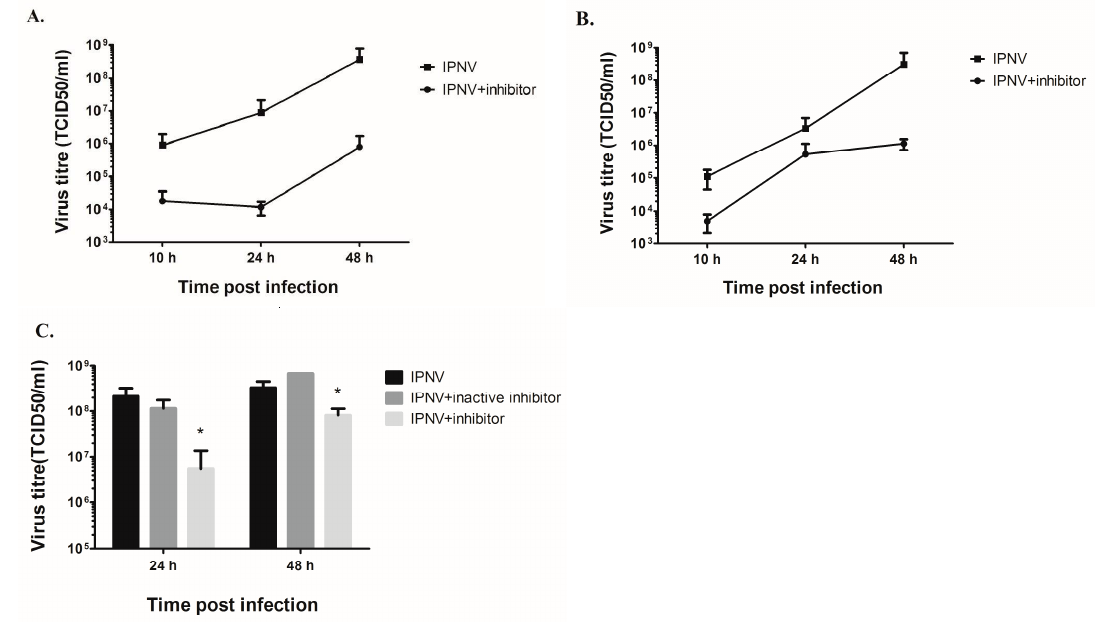
Figure 5. Effect of the PKR inhibitor C16 on IPNV replication. CHSE-214 ( A ) and TO ( B ) cells were either treated with 2 µM of the PKR inhibitor C16 or left untreated and then infected with IPNV at 20 PFU/mL and the amount of virus titers in the supernatants at different times post infection was determined by titration in CHSE-214 cells. Data represent an average of six parallels taken from two independent infections ± SD; ( C ) Virus titers in the supernatants in CHSE-214 cells following pretreatment with active and inactive form of C16 compared to untreated cells. Data represent an average of three parallels from a single infection ± SD. Asterisk indicate statistical significance compared to IPNV infected cells ( p < 0.05).